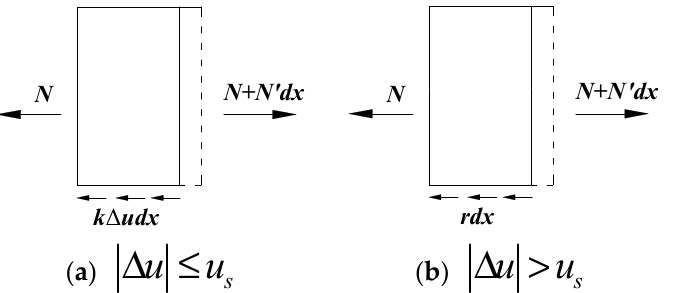
Figure 2. Longitudinal mechanical properties of rail microbody (under temperature variation).